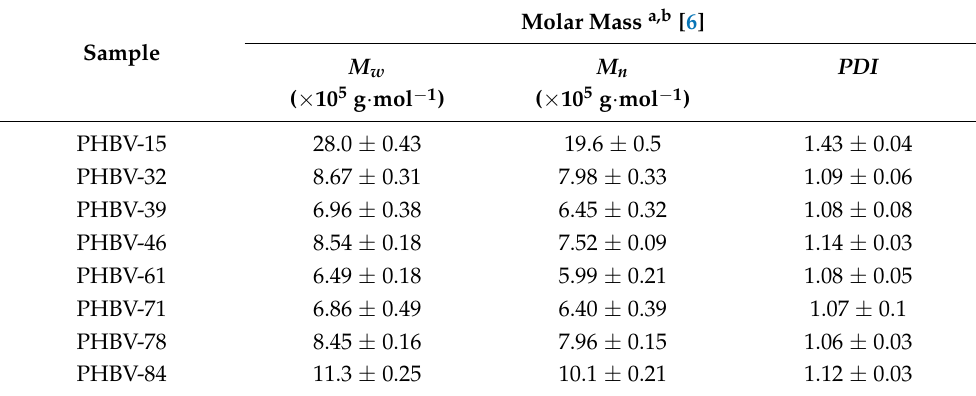
Table 2. Molar Mass and Poly dispersity index of purified PHBV obtained from CHCl 3 extraction of biomass a,b